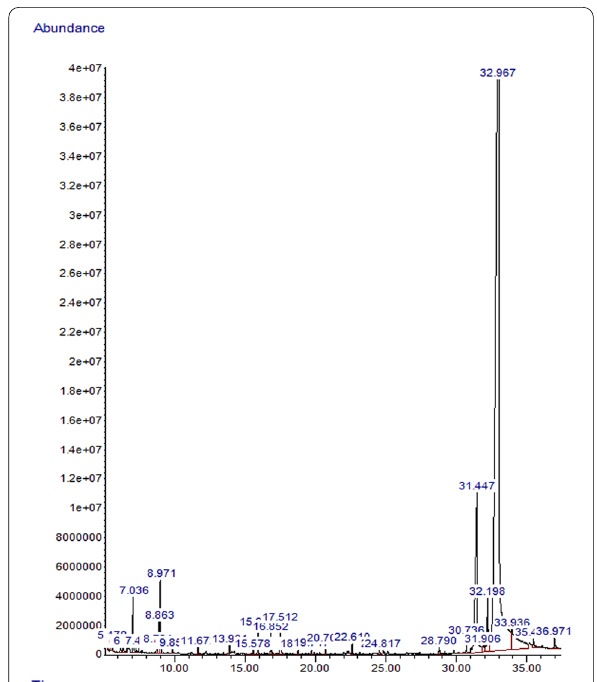
Fig. 2 Chromatogram of phytochemicals in the hexane extract of N. sativa seed